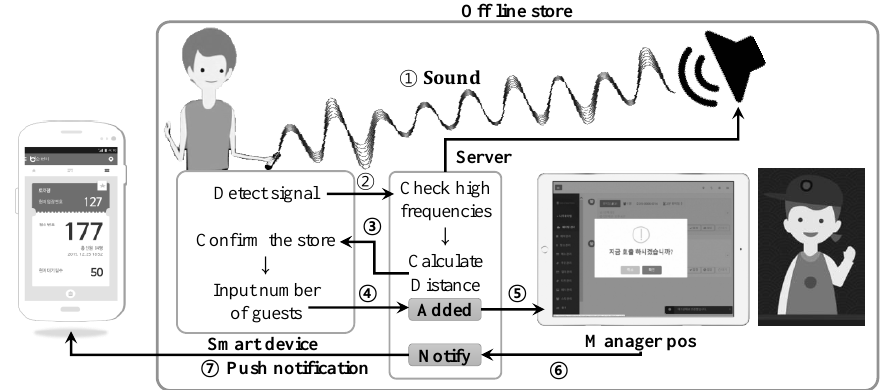
Fig. 1. Flow of the proposed application and server system